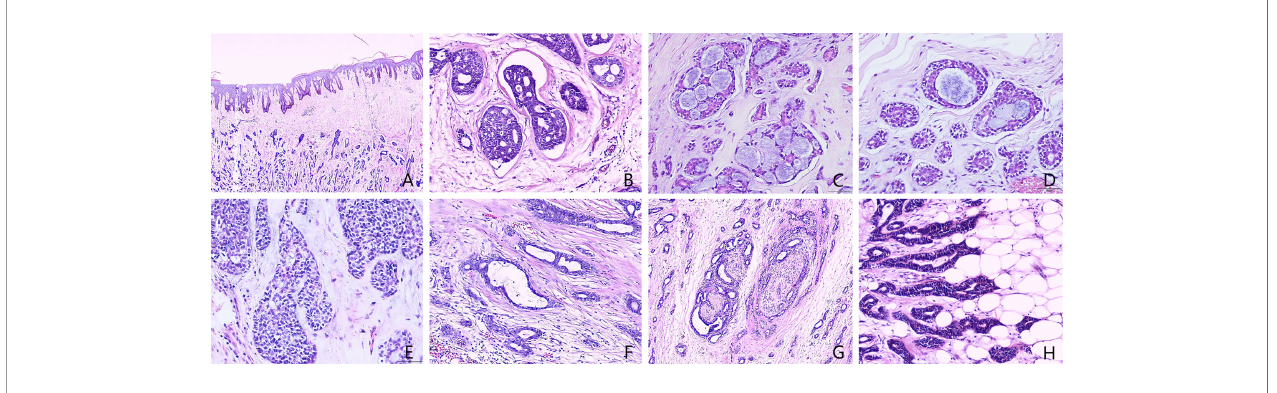
FIGURE 1 | Histopathology of male breast adenoid cystic carcinoma (Hematoxylin and eosin [H&E] stain). (A) Microscopic examination of the excised tissue revealed diffuse tumor invasion of the subcutaneous fi bers and adipose tissue. (B) Cribriform patterns and basement membrane materials around tumor nest. (C) Cribriform patterns and the cavities contain mucus secretion. (D) Tubular pattern and the cavities contain mucus secretion. (E) Solid patterns. (F) Microcystic patterns. (G) Neural invasion. (H) Adipose invasion. [ A : 40× magni fi cation; B – H : 400× magni